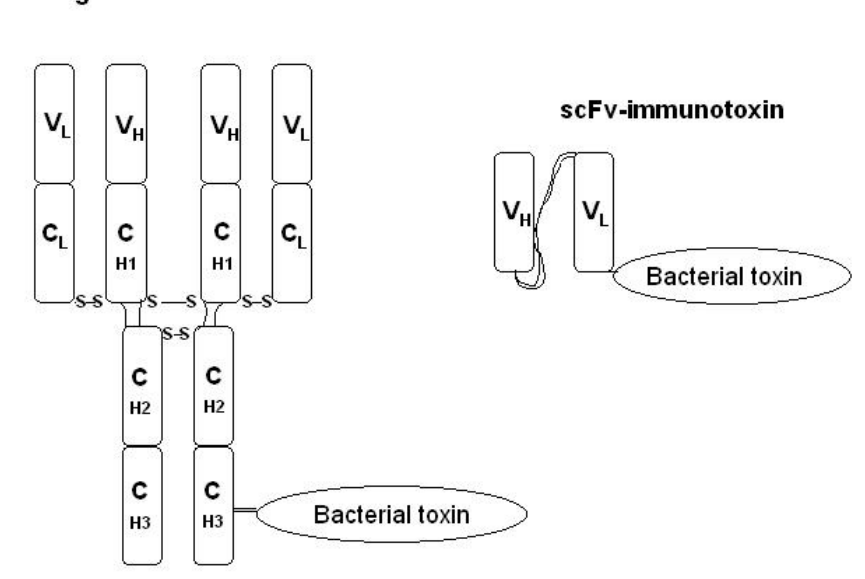
FIGURE 1. Schema for immunotoxins. The whole monoclonal antibody or scFv (V H and V L heterodimer) is conjugated with a truncated or mutated bacterial toxin, e.g., Pseudomonas